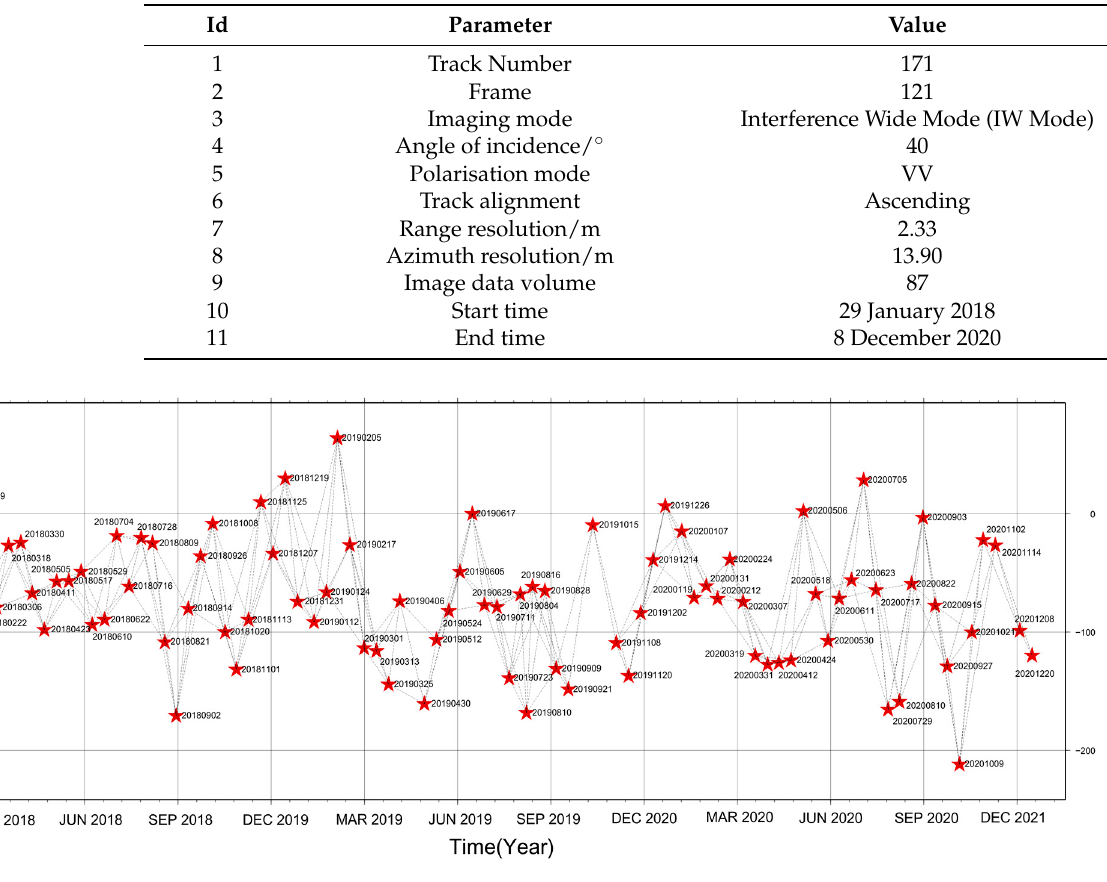
Figure 2. The small baseline network of ascending datasets (the pentagram represents each SAR image).